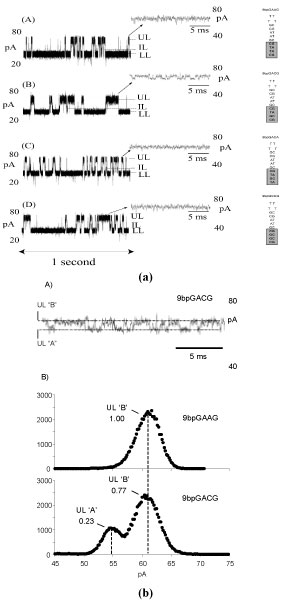
Preliminary results add credence to the hypothesis that the UL state has an unbound terminus, and that while in that state conformational switching may be observable (from [8]). For the molecules and blockades shown (a) above, three are found by NMR to have one dominant ground state (no switching), while one of the molecules is found by NMR to have two dominant low energy states (switching). This corresponds exactly with what has been observed in terms of the existence of fine structure (toggling) in the UL blockade state, as shown in (b).